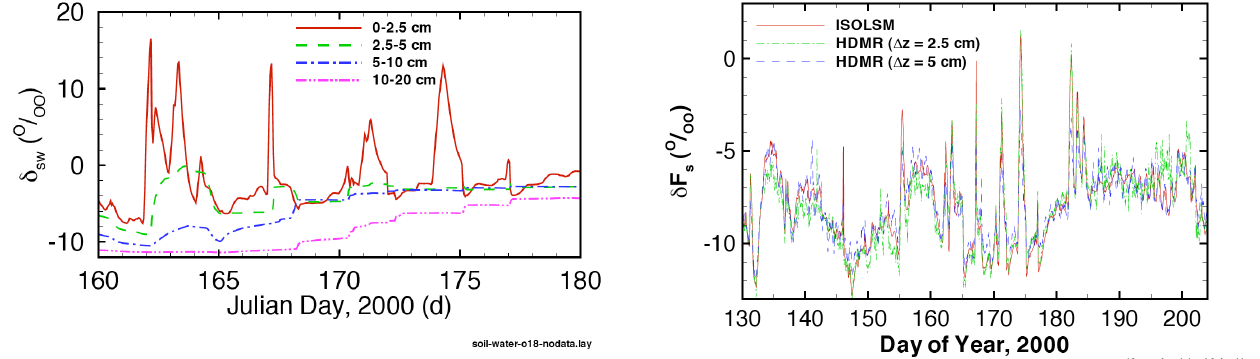
Fig. 2. Simulated δF s over the growing season from ISOLSM and Figure 2. Simulated δ F s over the growing season from ISOLSM and the HDMR approach 2 the HDMR approach using discretization scenarios D 1 and D 2 . using discretization scenarios D 1 and D 2 . Variability in δ F s is large when δ sw variability in 3 Variability in δF s is large when δ sw variability in the top 2.5 or 5cm is the top 2.5 or 5 cm is large. 4